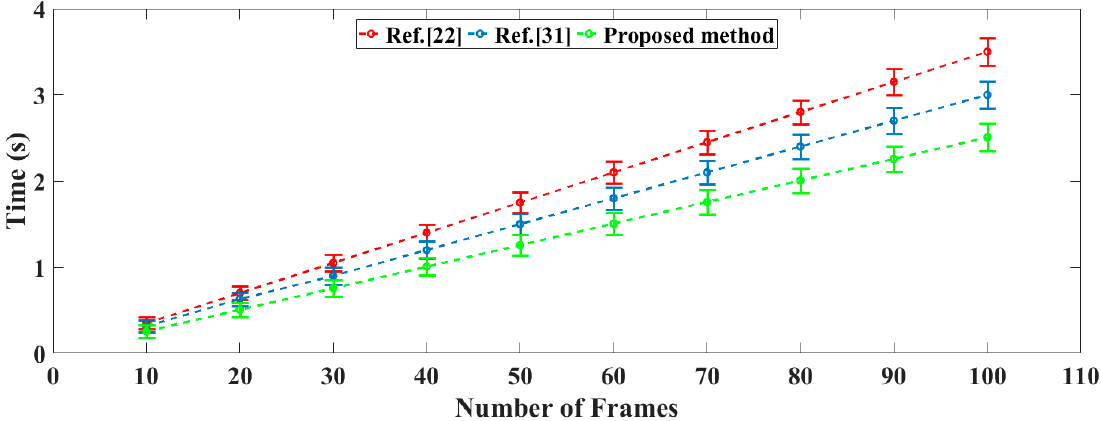
Figure 3. The time consumed for the bias estimation.